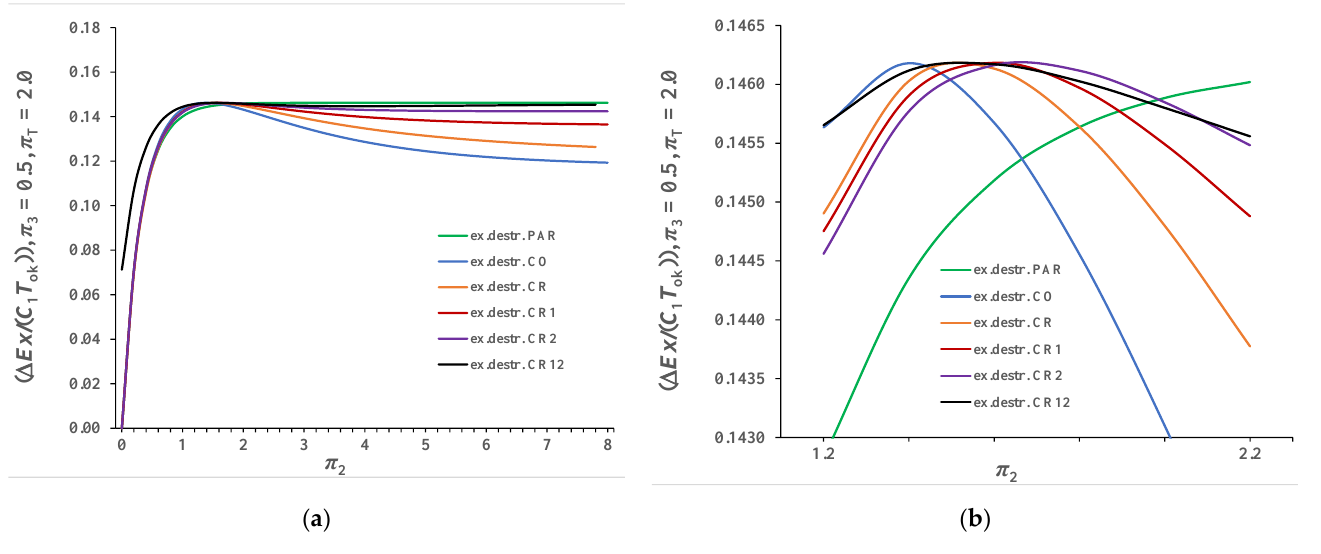
Figure 10. Dependence of exergy destruction on π 2 for π T = 2.0 and π 3 = 0.50: ( a ) 0 < π 2 < 8.0; ( b ) 1.2 < π 2 < 2.2. The diagrams in Figure 11a,b show the values of exergy destruction of all recuperators as a function of π 2 with π T = 0.50 and π 3 = 1.0. The obtained values of exergy destruc- tion, using Equations (20) and (39), are lower than the values shown in Figures 9a,b and 10a,b. It is interesting to note here that the obtained values of exergy destruction are equal for a cross-flow recuperator with mixing streamlines only of a weaker stream and for a cross-flow recuperator with mixing streamlines only of a stronger stream.